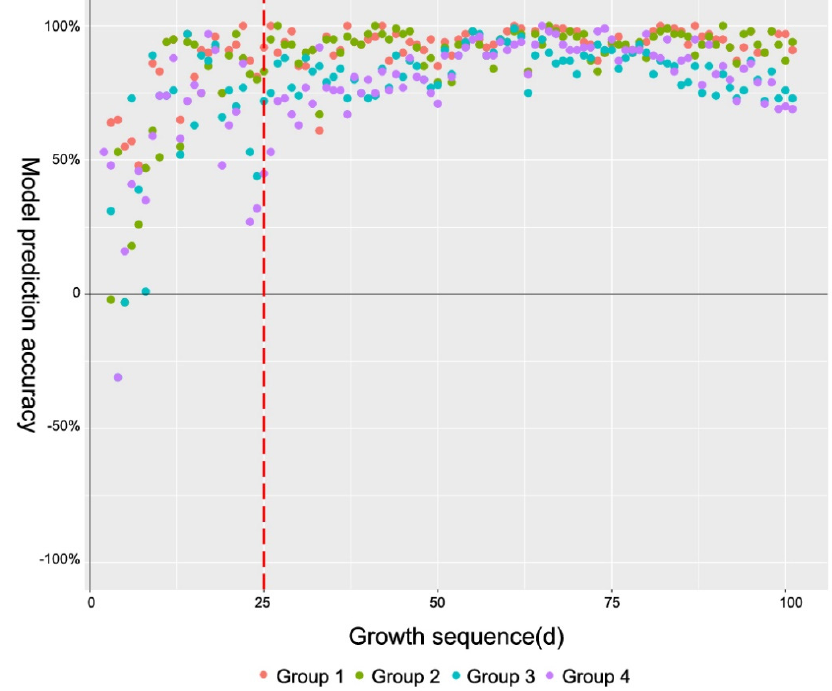
Figure 8. Scatter plot of inversion accuracy of Y26 for the samples of four groups. The figure shows only the inversion accuracy values in the interval [ − 1, 1]. The red dotted line in the figure caption is the auxiliary observation line at the 25th day of growth sequence.